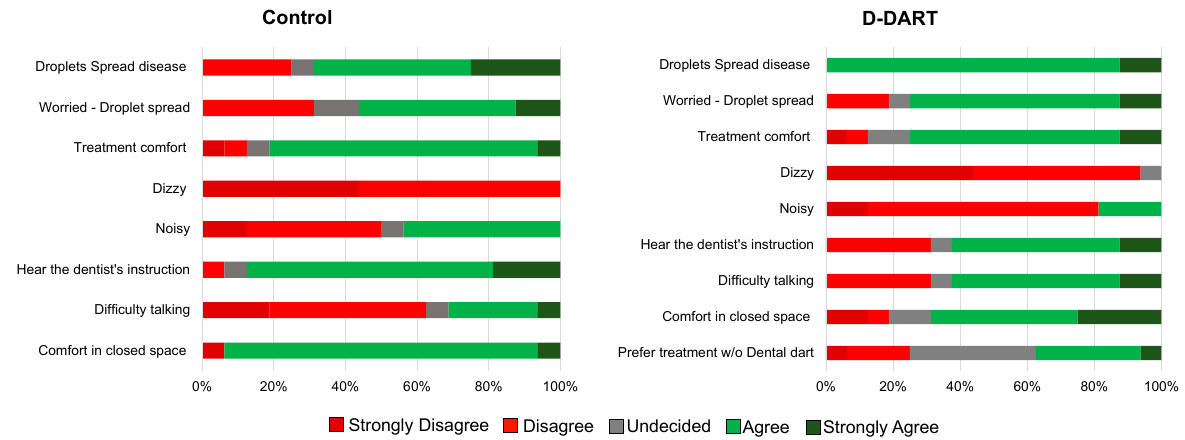
Figure 3. Patient feedback. No major discomfort was reported by most patients treated with the D- DART.